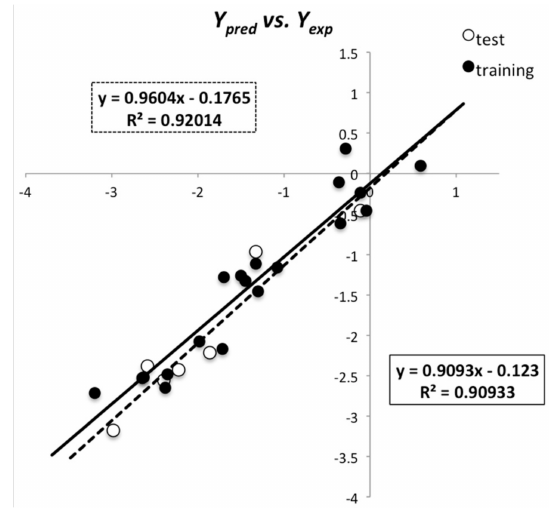
Figure 1. Log(1 / MIC) pred vs. log(1 / MIC) exp according to the best built QSAR